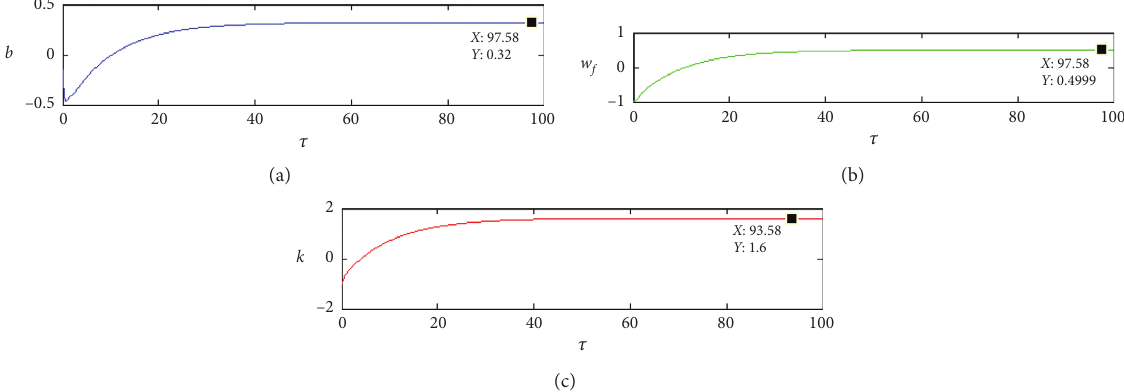
, and k converging asymptotically to (a) 0.32 (in blue), (b) 0.5 (in green), and f